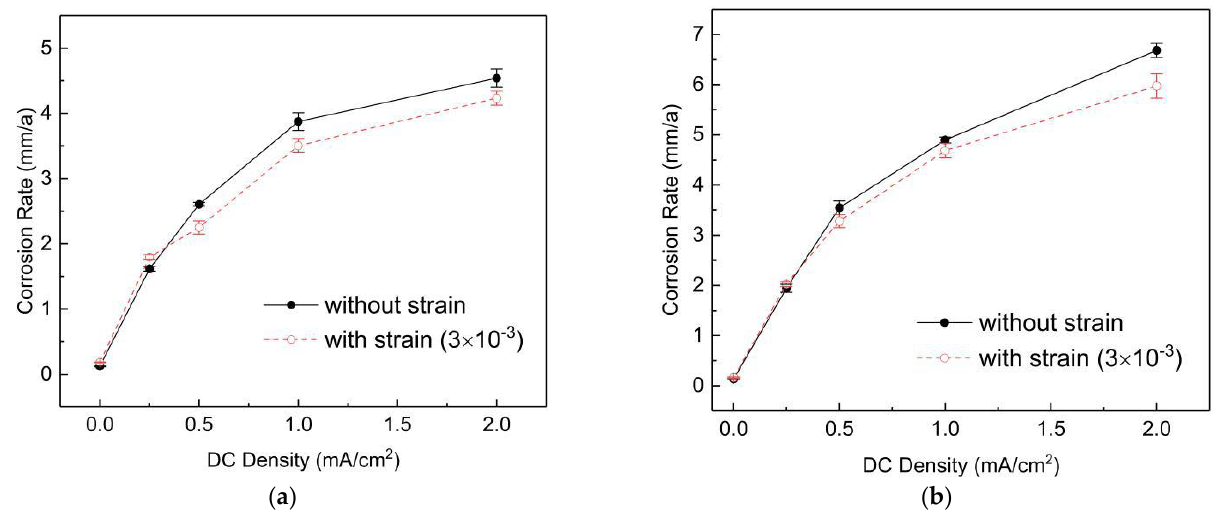
Figure 14. The corrosion rates of X80 steel samples in NS4 solution as a function of i DC and strain: ( a ) obtained by LPR; ( b ) obtained by EIS curve.